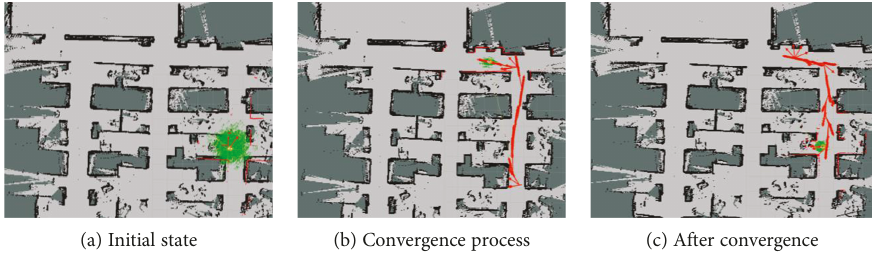
Figure 7: Mobile robot global localization process based on